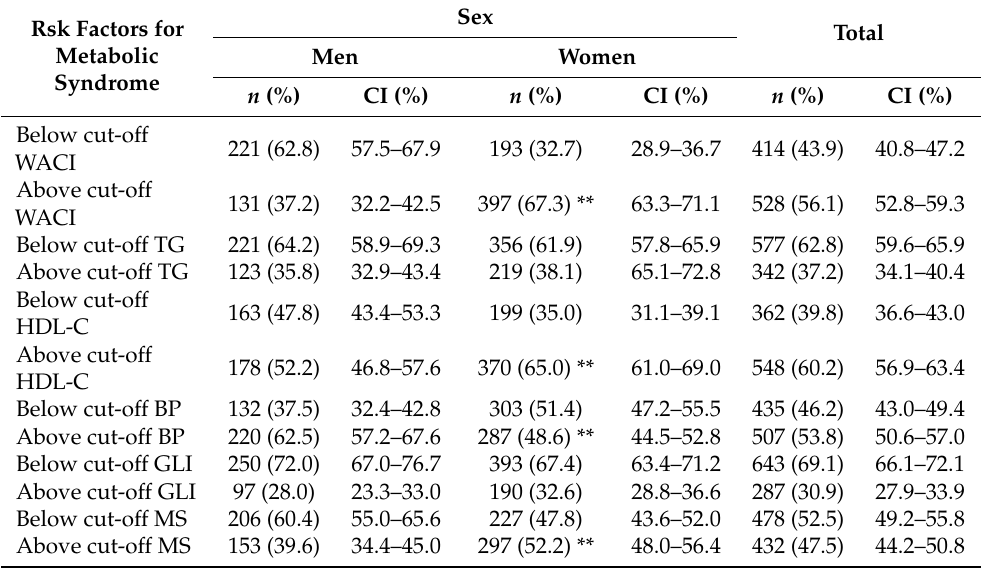
Table 2. Sex-related differences in the prevalence of each individual risk factor for metabolic